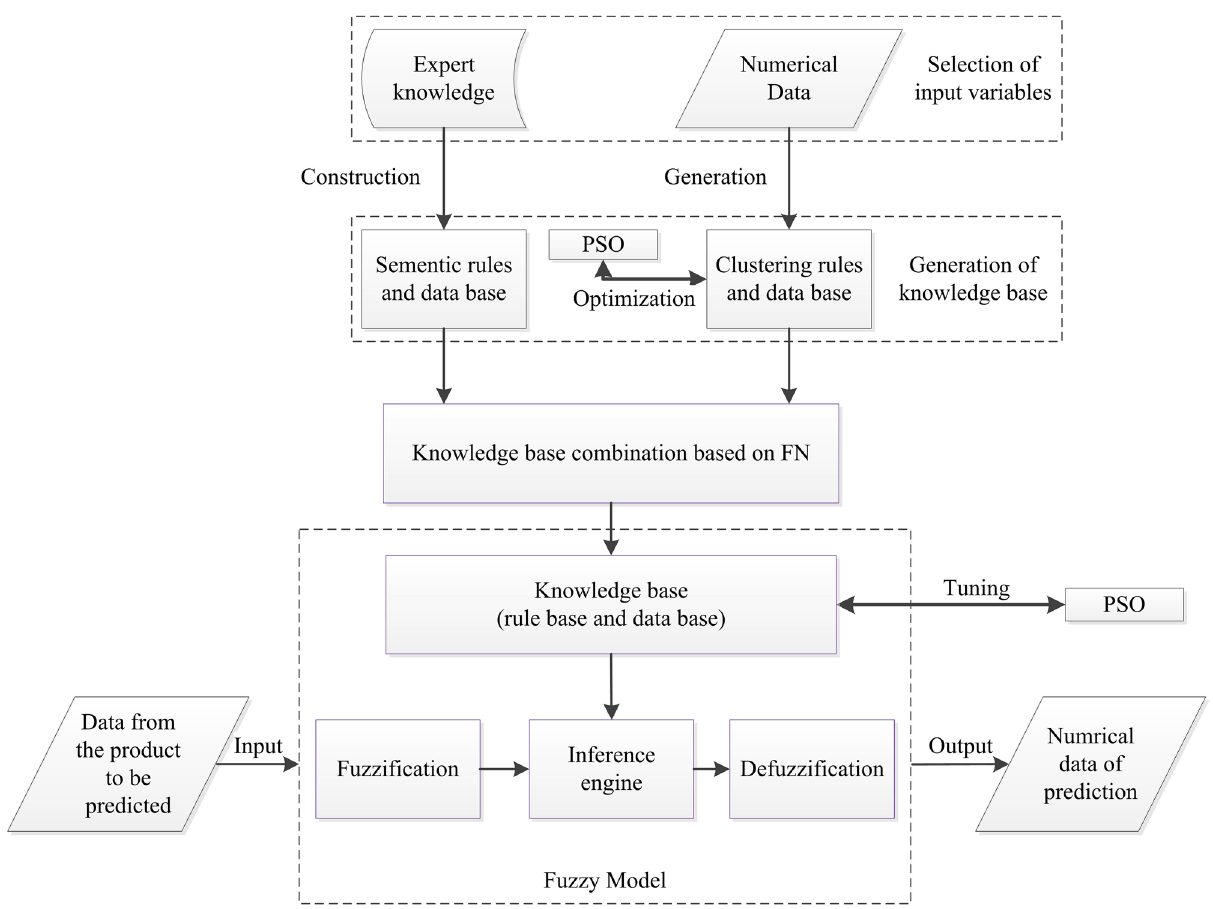
Figure 6. Flow sheet of construction the FCM-FN model.